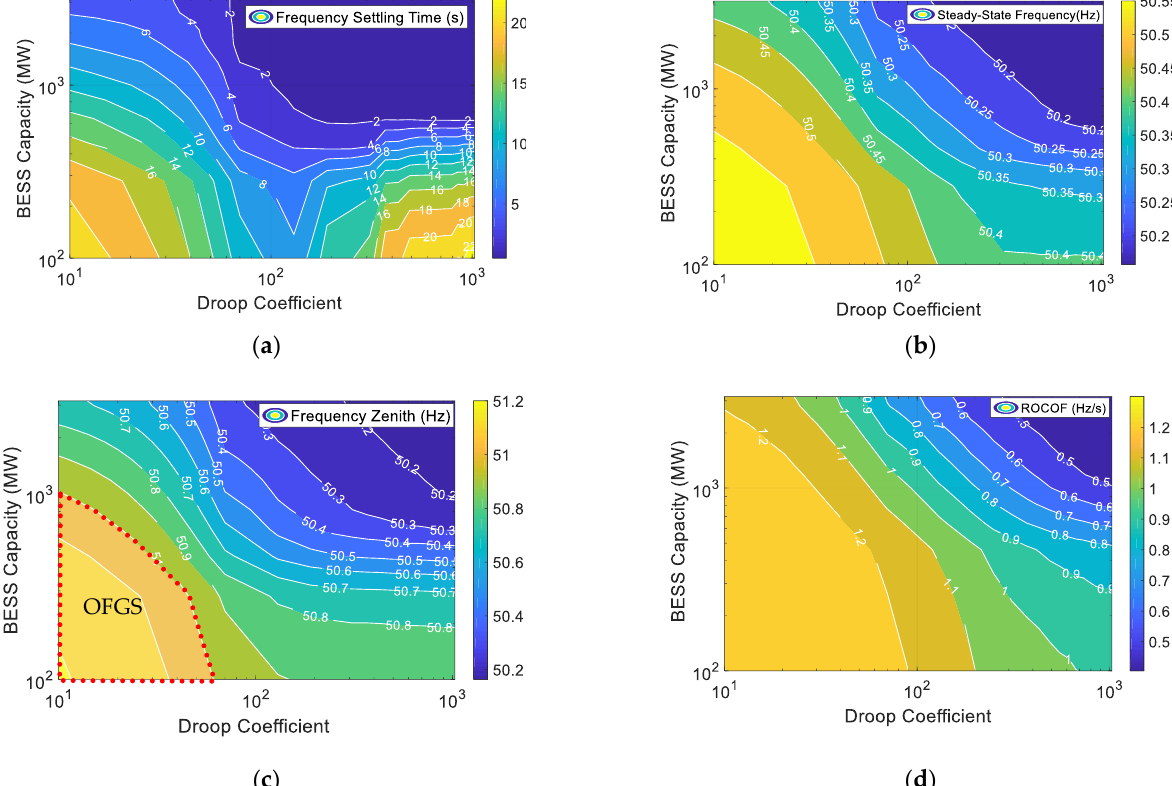
Figure 12. ( a ) Frequency settling time; ( b ) steady-state frequency; ( c ) frequency zenith; and ( d ) ROCOF for different capacities and droop coefficients of BESS, when both BESS and SG participate in PFC.